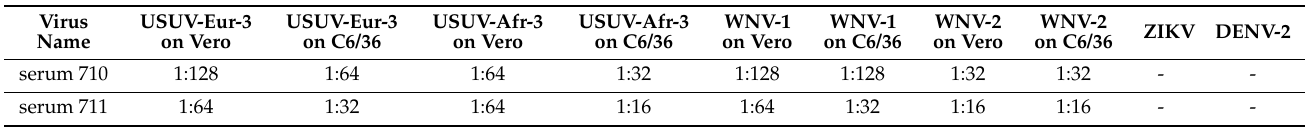
Table 2. Results of the microneutralization assay. Numbers show the highest dilution of the sera where the infection of the cells was blocked by neutralizing